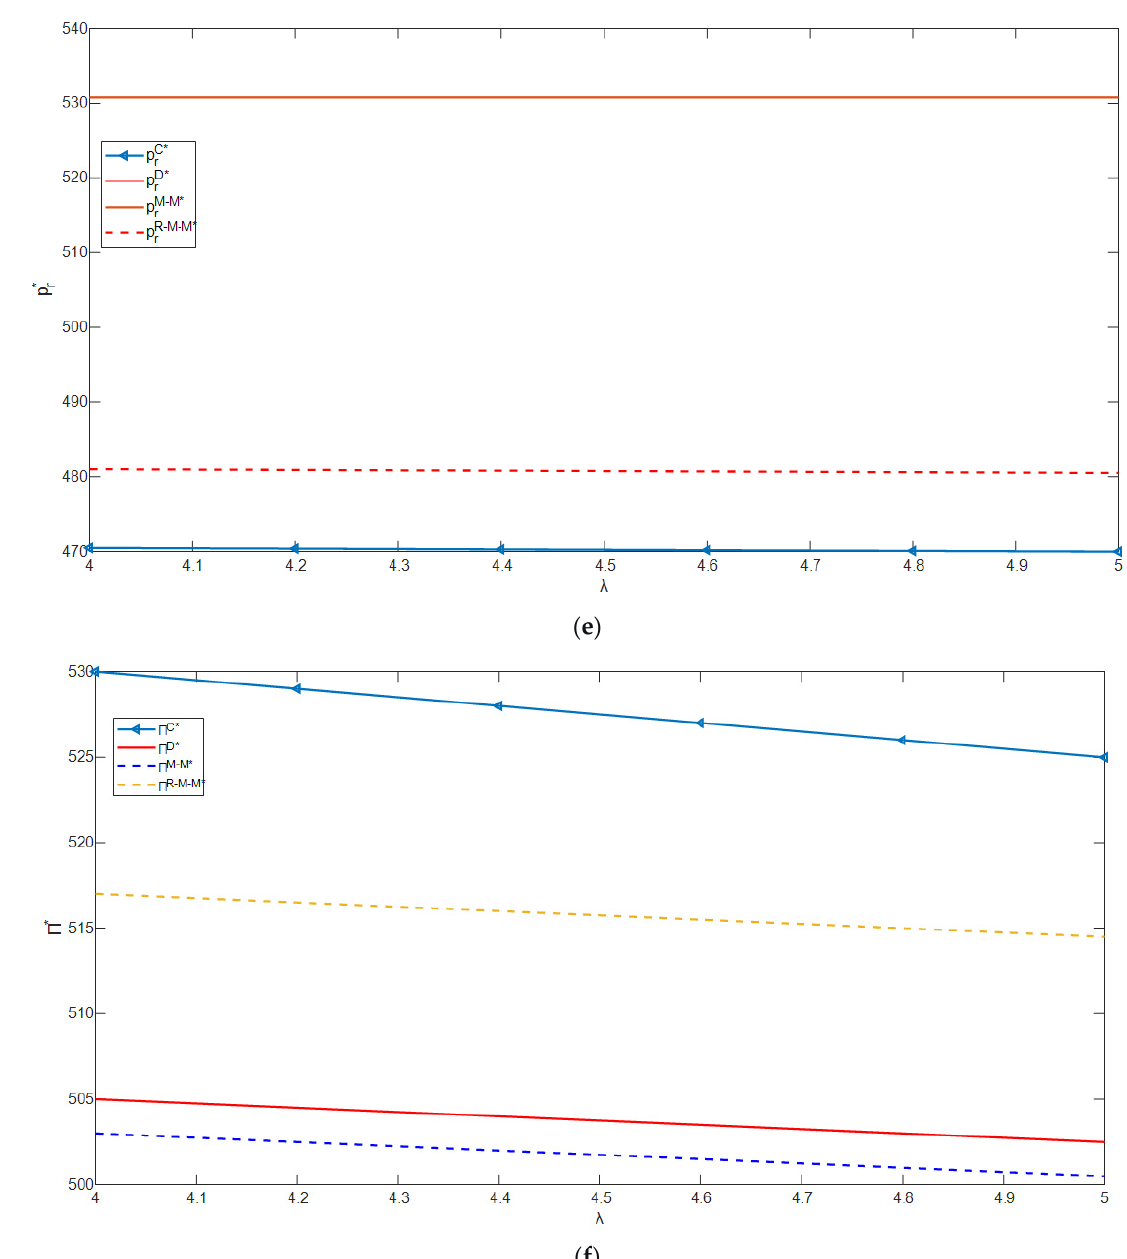
Figure 2. The impact of λ on the equilibrium results. ( a ) The impact of λ on e ∗ ; ( b ) the impact of λ on g ∗ n ; ( c ) the impact of λ on g ∗ r ; ( d ) the impact of λ on p ∗ n ; ( e ) the impact of λ on p ∗ r ; ( f ) the impact of λ on π ∗